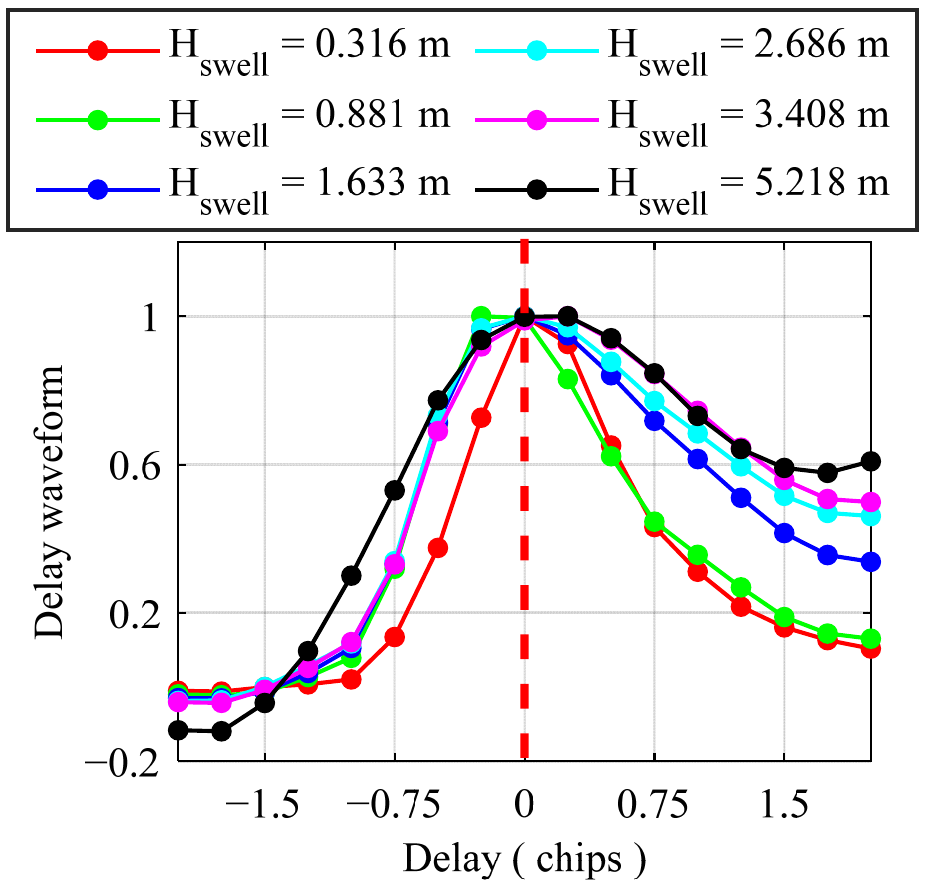
Figure 3. NIDW with different swell height (H swell ). The red dotted line divided the waveform into 2. In Figure. 9, the graph size of Figure. 9 (c) and Figure. 9 (d) is inconsistent with two parts, leading edge and trailing